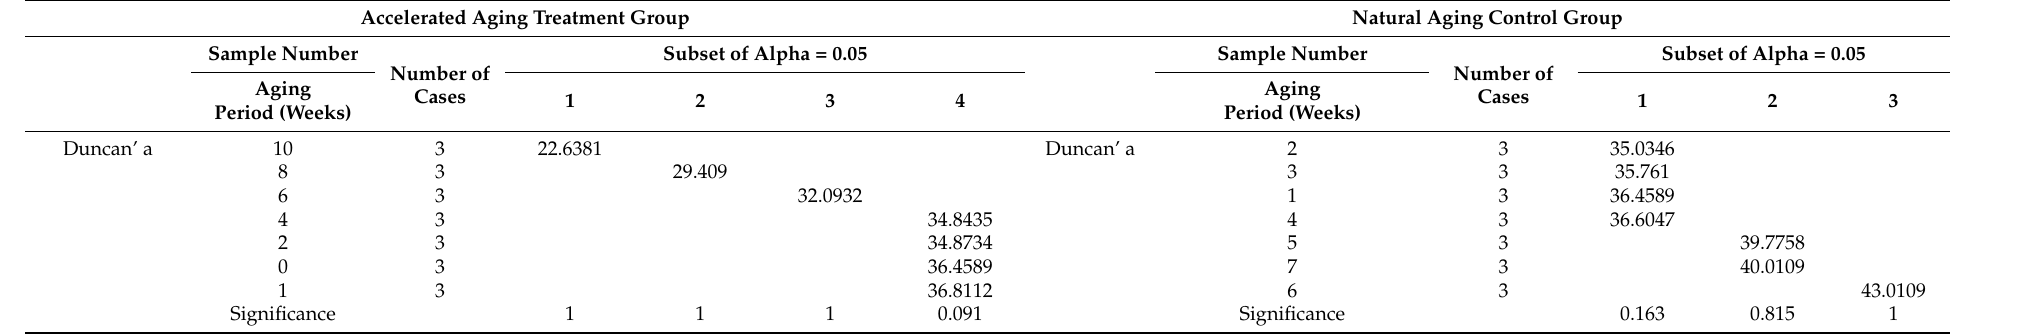
Table 4. Numerical significance analysis of cellulose crystallinity during aging of